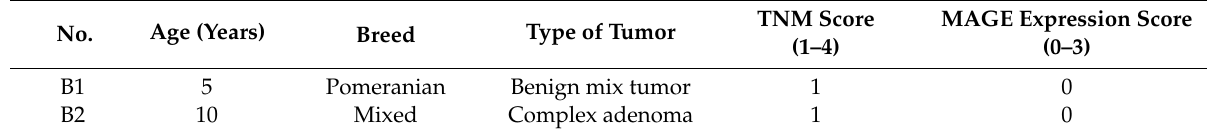
Table 2. Results of canine MAGE antigen recognized human MAb 6C1 in benign CMT tissues.